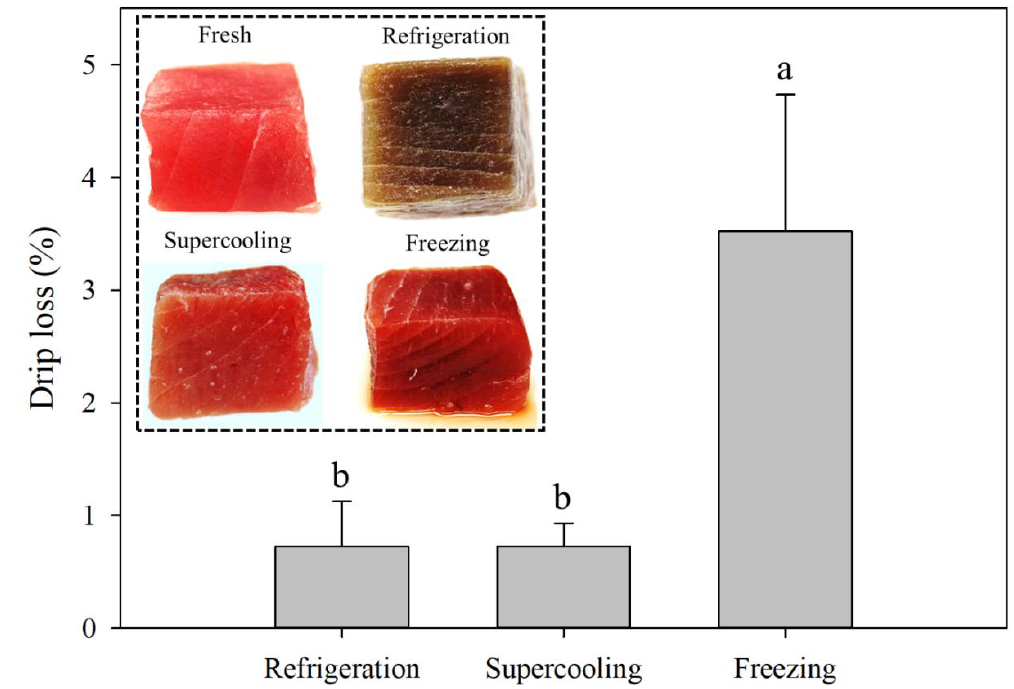
Figure 5. Mean vales of drip loss and the visual appearance (inserted figure) of tuna samples (80 g) stored for 8 days under the refrigeration, supercooling, and freezing. Error bars represent standard deviations, and different letters indicate significant differences ( p < 0.05) between treatments.